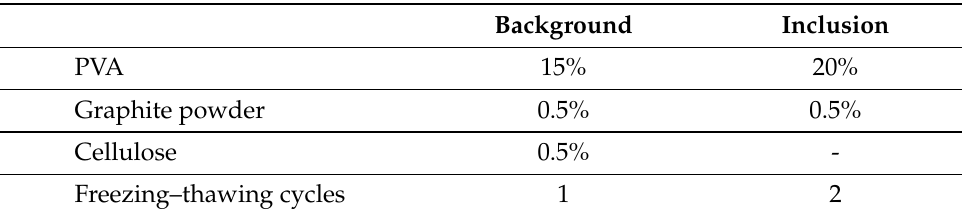
Table 1. Weight percentage ( w / w ) of the ingredients for fabricating the background phantom and